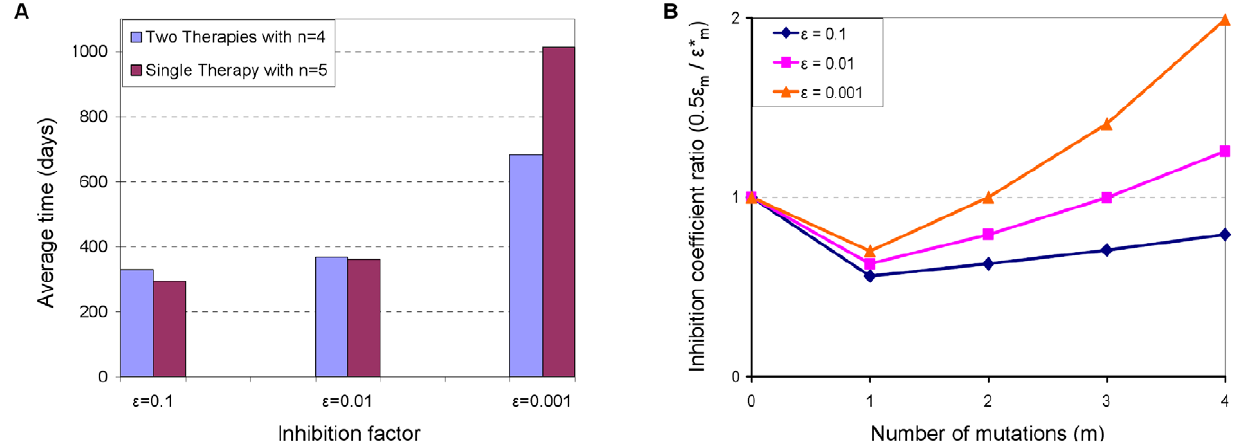
Figure 6. Efficacies of different combinatorial gene therapy strategies. Two strategies are considered: protecting the entire P cell population with a single gene-based inhibitor whose genetic barrier is n ~ 5 , and dividing the P cell population into two sub-populations, such that each one is protected by a different gene-based inhibitor whose genetic barrier is n ~ 4 . (A) The efficacies of the two strategies are compared in terms of their resultant average fixation times, for three different inhibition factors ( e ). All other parameters are set to their default values (see the Methods section). The different relations between fixation times that are observed for different e values suggest that none of the strategies is universally advantageous. Data are based on the outcomes of 500 simulation runs per each parameter set, similar to Figure 4. (B) The ratio between the approximate inhibition levels that each strategy exerts on a given strain is depicted (y-axis) as a function of the number of mutations ( m ) a strain possesses (x-axis), for each of the three considered e values. The ratio is greater than one when the single-therapy strategy inhibits a strain more potently than the two-therapy strategy, and vice versa. It can be seen that the ratios correlate with the advantageous strategy, that is, larger ratios pertain to improved performance of the single-therapy strategy.